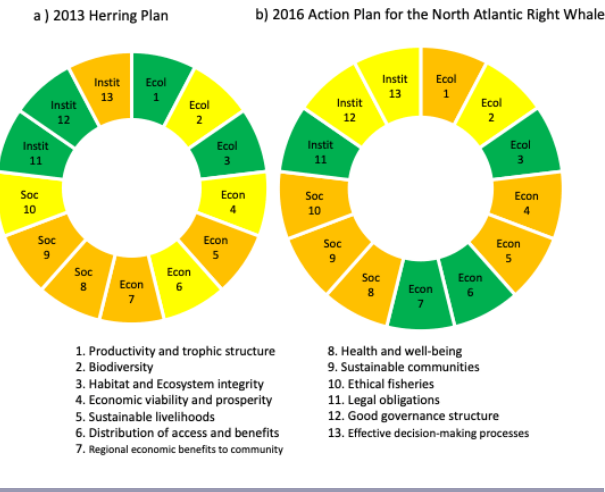
Fig. 2 . Comparison of the two management plans evaluated with the Canadian Fisheries Research Network framework: (a) 2013 Herring Plan and (b) 2016 Action Plan for the North Atlantic Right Whale. Green scores indicate detailed mentions within the management plan, yellow scores indicate scant mention, and orange scores indicate no mention. Words within slices refer to objective category (Ecol, ecological; Econ, economic; Instit, institutional; Soc, social), and numbers correspond to list of objectives